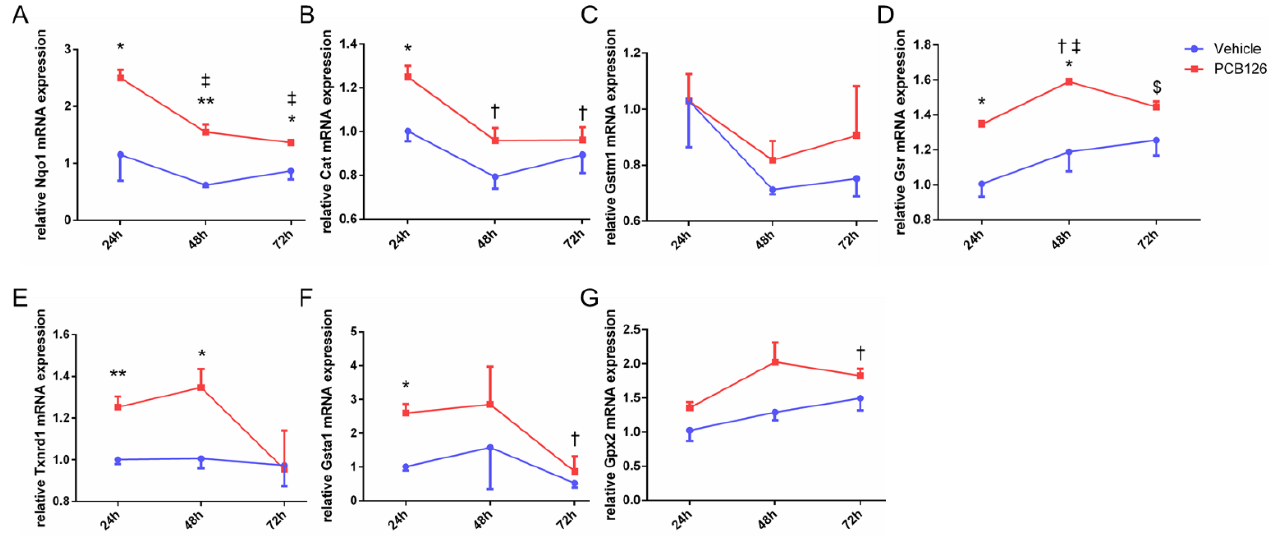
Figure 3. mRNA expression of 7 antioxidant genes, including Nqo1 ( A ), Cat ( B ), Gstm1 ( C ), Gsr ( D ), Txnrd1 ( E ), Gsta1 ( F ), and Gpx2 ( G ), that are regulated by the NRF2 pathway is measured in the MCECs after 24, 48, and 72 h of treatment with the vehicle (Blue) or 4.4 um PCB 126 (Red). Sample size: n = 3. Data are shown as the mean ± SEM. When compared with the treatment counterparts, * p ≤ 0.05 and ** p ≤ 0.01. When compared with 24-h counterparts among the PCB 126-treated groups, † p ≤ 0.05, ‡ p ≤ 0.01, and † ‡ p ≤ 0.001. When compared with the 48-h counterparts among the PCB 126-treated groups, $ p ≤ 0.05.